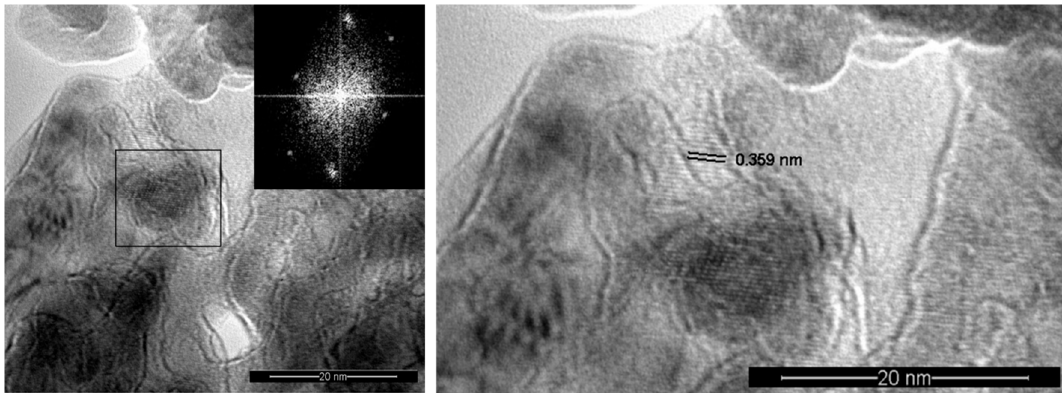
Figure 6. High resolution TEM image with inset of the corresponding fast Fourier transformer presentation of the selected area of the TiO 2 buffer layer deposited at 10 Pa oxygen (TO10) ( left ) and a detail showing the interplanar distance corresponding to the anatase (101) plane ( right ).